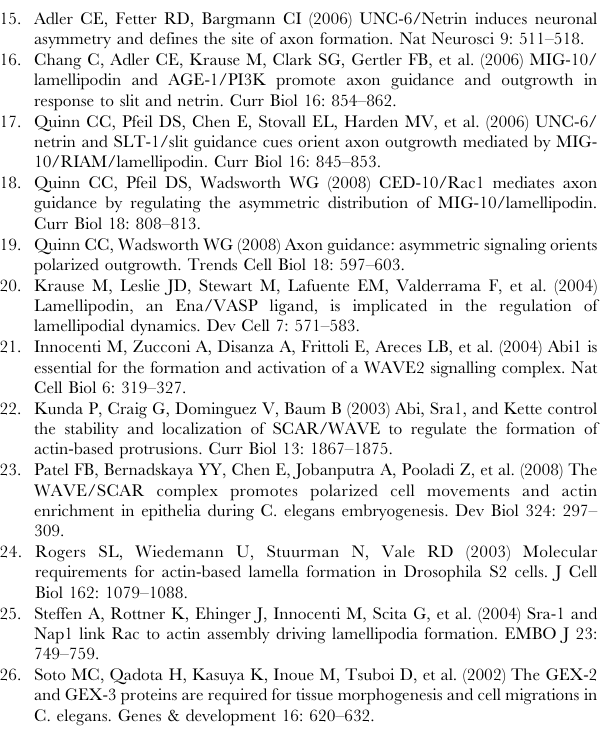
Figure S2 ABI-1 functions downstram of UNC-40. A mec-7::unc- 40 transgene was used to overexpress UNC-40 in the PVM neuron. Overexpression of UNC-40 caused ventral axon guidance defects in the PVM neuron. These guidance defects were suppressed by an abi-1(tm494) loss of function mutation. Error bars represent standard error of the proportion. *Statistically significant difference compared to wild-type animals, z-test for proportions (p , 0.05). Figure S3 Loss of abi-1 function suppresses MIG-10 outgrowth- promoting activity. The PVM neuron normally has a single process growing out of its cell body. Transgenic expression of MIG-10 in the unc-6; slt-1 double mutant background produces a multipolar phenotype, where one or more additional processes grow out of the PVM cell body. This outgrowth-promoting activity of MIG-10 is suppressed by the abi-1(tm494) loss of function mutation. *Statistically significant difference compared to unc-6; slt-1 double mutant, z-test for proportions (p , 0.0001). Figure S4 Model for redundant physical interactions between molecules involved in axon guidance. The observations presented in this paper indicate that MIG-10 binds to ABI-1. A previous report has indicated that activated CED-10 binds to MIG-10 [18]. Previous work has also defined the Wave complex, consisting of Sra-1 (GEX-2), Nap1 (GEX-3), Abi1 (ABI-1), and Wave (WVE-1). A subcomplex consisting of Sra-1 (GEX-2) and Nap1 (GEX-3) can bind to activated Rac (CED-10) and also to another subcomplex consisting of Abi1 (ABI-1) and (Wave) WVE-1 [21].